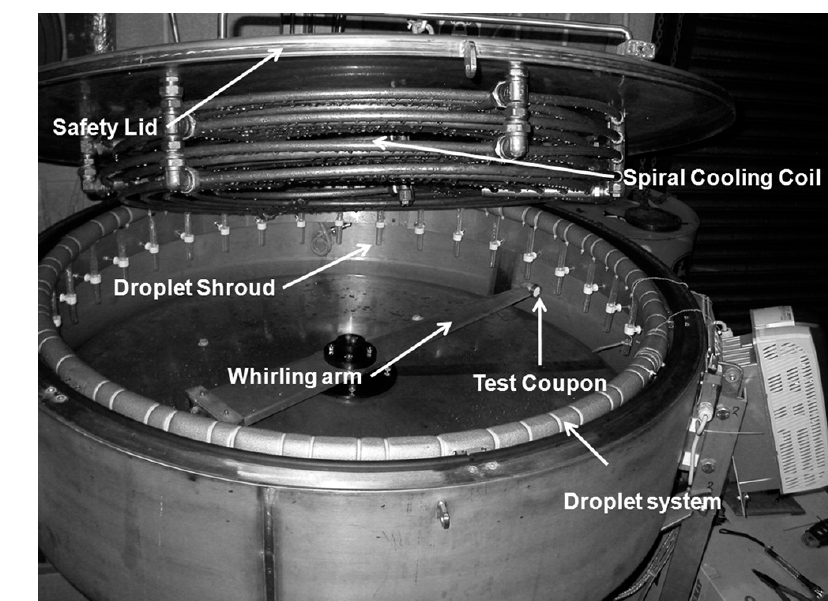
Figure 14. Example of Whirling Arm apparatus [117].